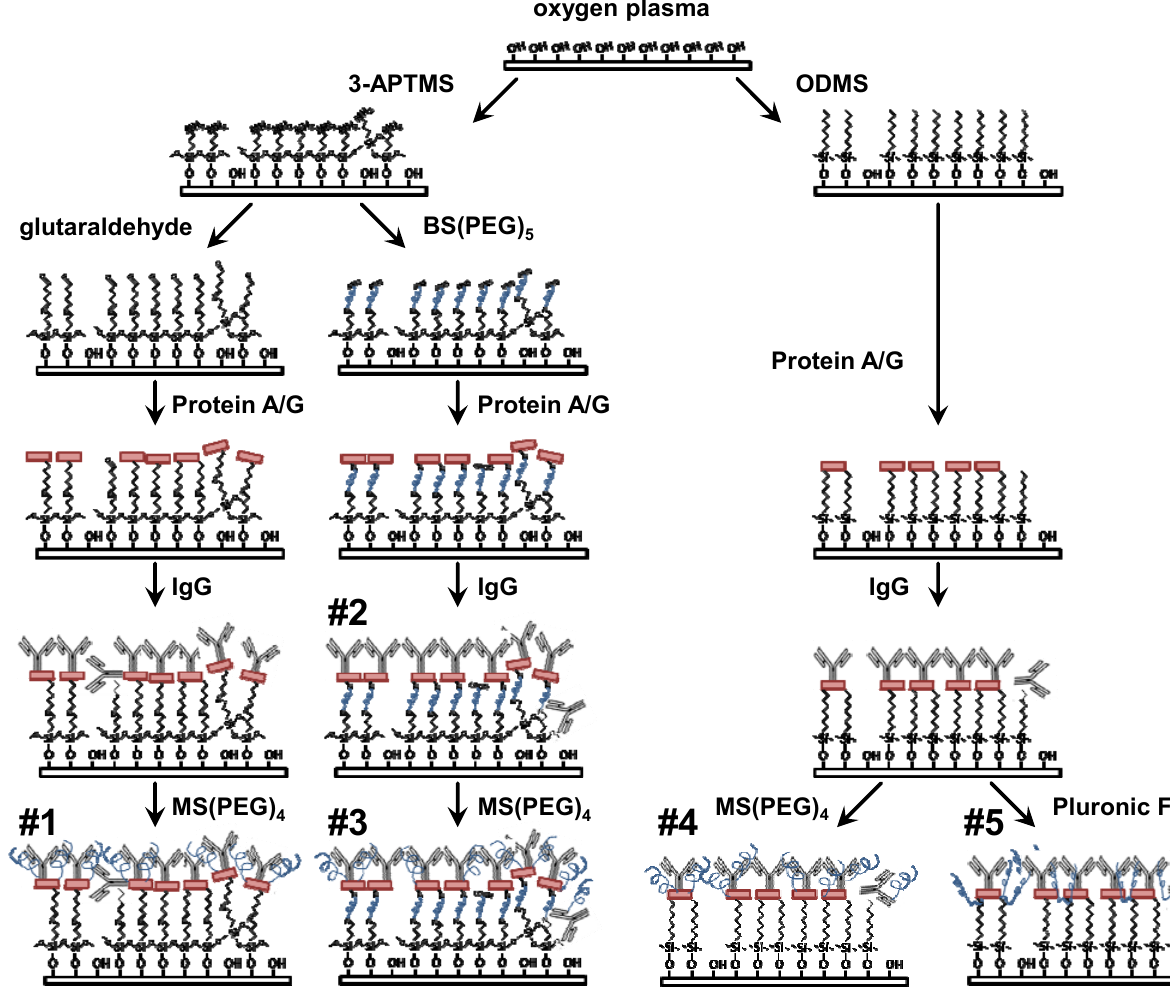
Figure 1. Five surfaces were engineered by sequential assembly with reagents that control the capture antibody orientation and prevent non-specific protein